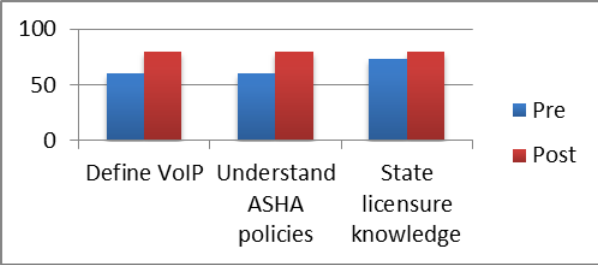
Figure 1. Percentage of providers who were able to correctly respond to telehealth quiz questions before and after the in- service